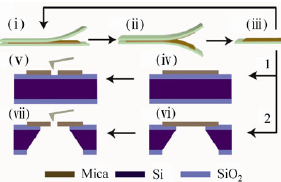
Figure 18. Schematic illustration of few-layer mica cleavage and conical nanopore fabrication. ( i – iii ) A freshly cleaved bulk muscovite mica sheet is attached to a sticky tape. Few-layer mica is prepared by repeatedly peeling off small flakes with other fresh pieces of tape.The peeled flakes can be transferred onto the top of either a solid silicon substrate (route 1) or a silicon window (route 2) for further characterization and processing. Nanopores can be fabricated in both solid ( iv ) and ( v ), and suspended ( vi ) and ( vii ) few-layer mica membranes by AFM processing with a certain mechanical load. Reprinted with permission from reference [144]. Copyright 2012 Springer.